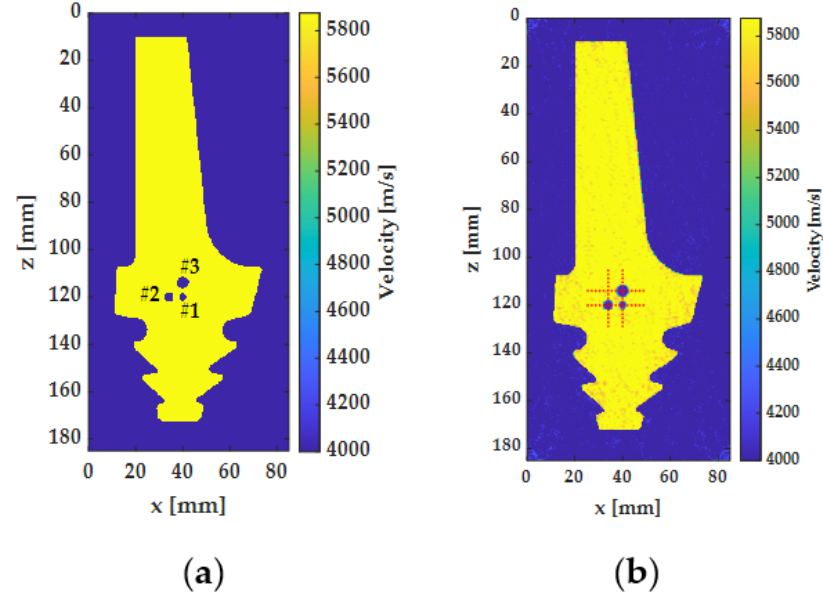
Figure 13. ( a )True model and ( b ) FWI tomograph of three defects. Figure 13. ( a ) True model and ( b ) FWI tomograph of three